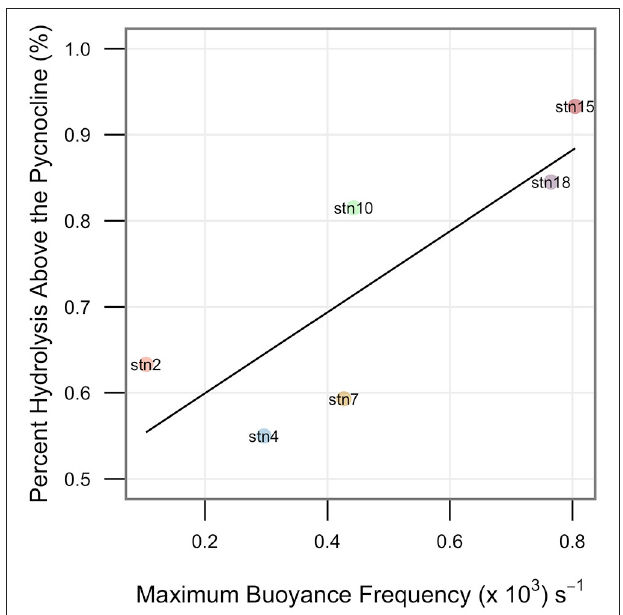
FIGURE 4 | Percent of hydrolysis occurring above the pycnocline at each station is positively correlated with the maximum buoyancy frequency at that station. R 2 = 0.66, P = 0.048.